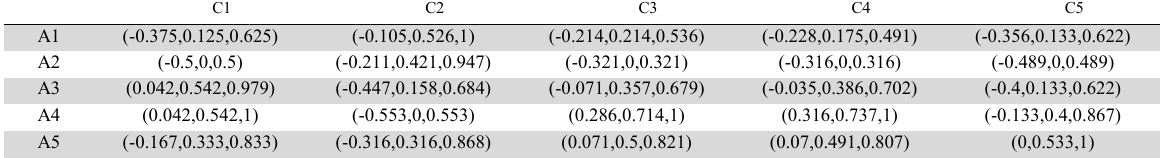
Weighted normalized decision matrix